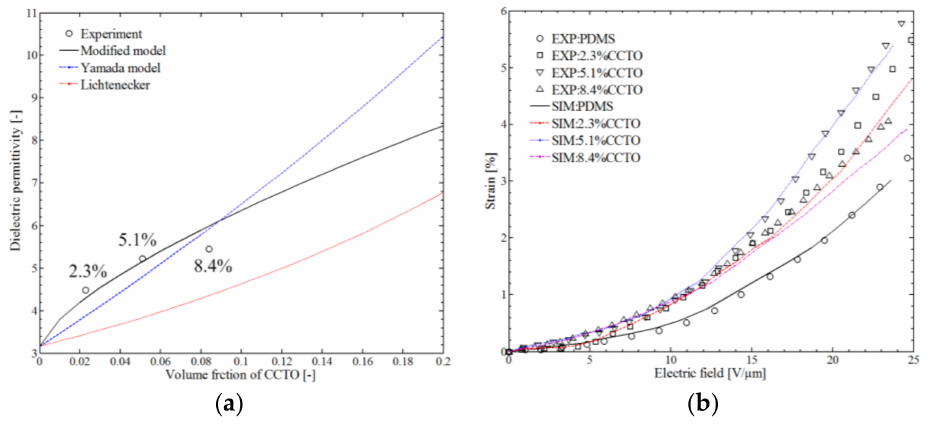
Figure 16. Simulation results of the CaCu3Ti4O12 (CCTO)–PDMS: ( a ) dielectric permittivity; ( b ) electromechanical behavior